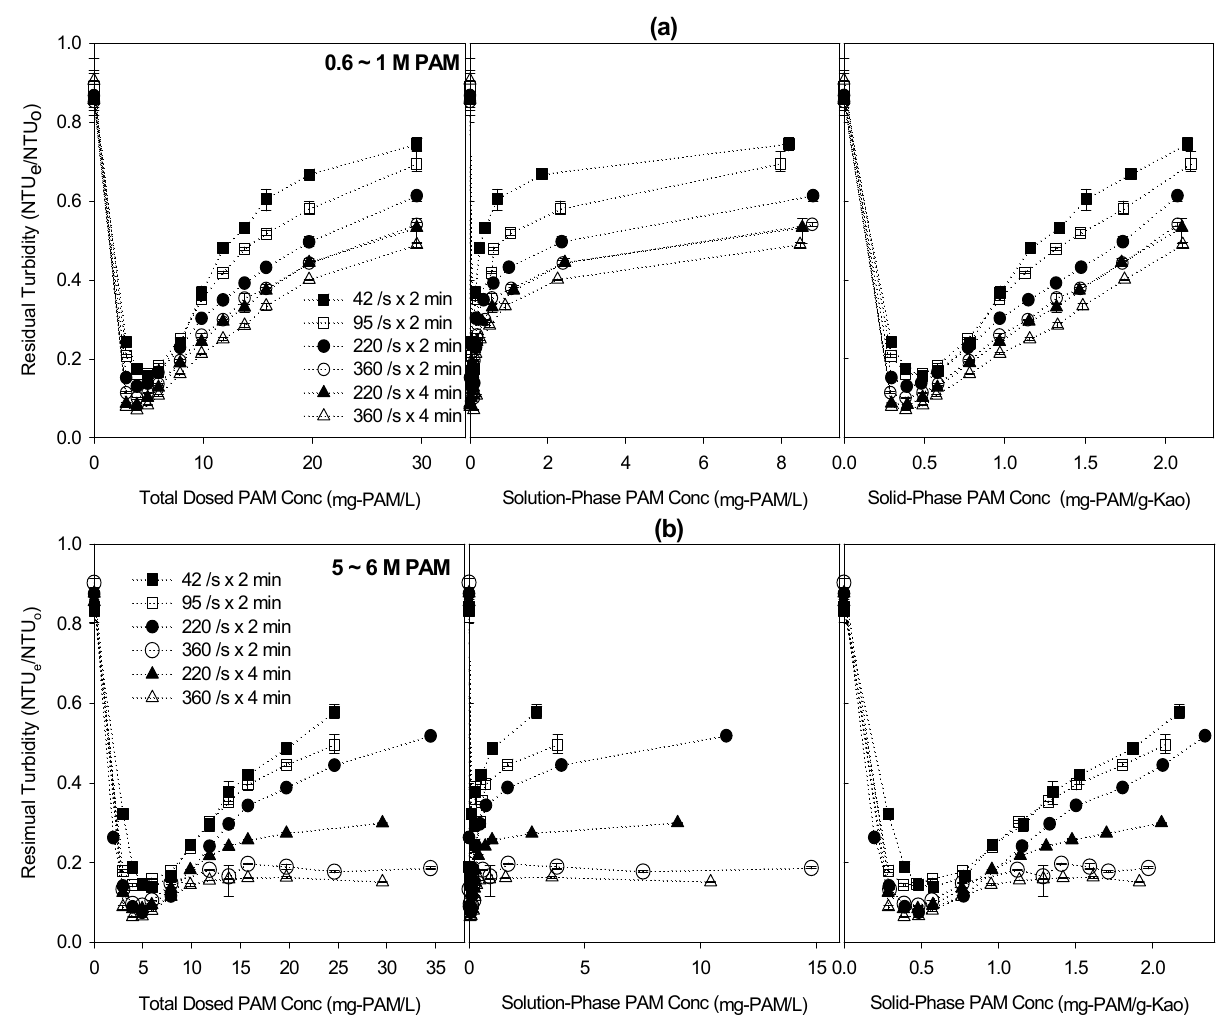
Figure 5. Experimental results of flocculation tests performed using 0.6–1 M and 5–6 M polyacrylamides (PAMs) at different shear rates and contact times. ( a , b ) represent the residual turbidity (final turbidity/initial turbidity) versus PAM concentrations for 0.6–1 M and 5–6 M, respectively. The x-axis represents the total dosed PAM concentrations in the left-hand panels, the solution-phase PAM concentrations in the middle panels, and the solution-phase PAM concentrations in the right-hand